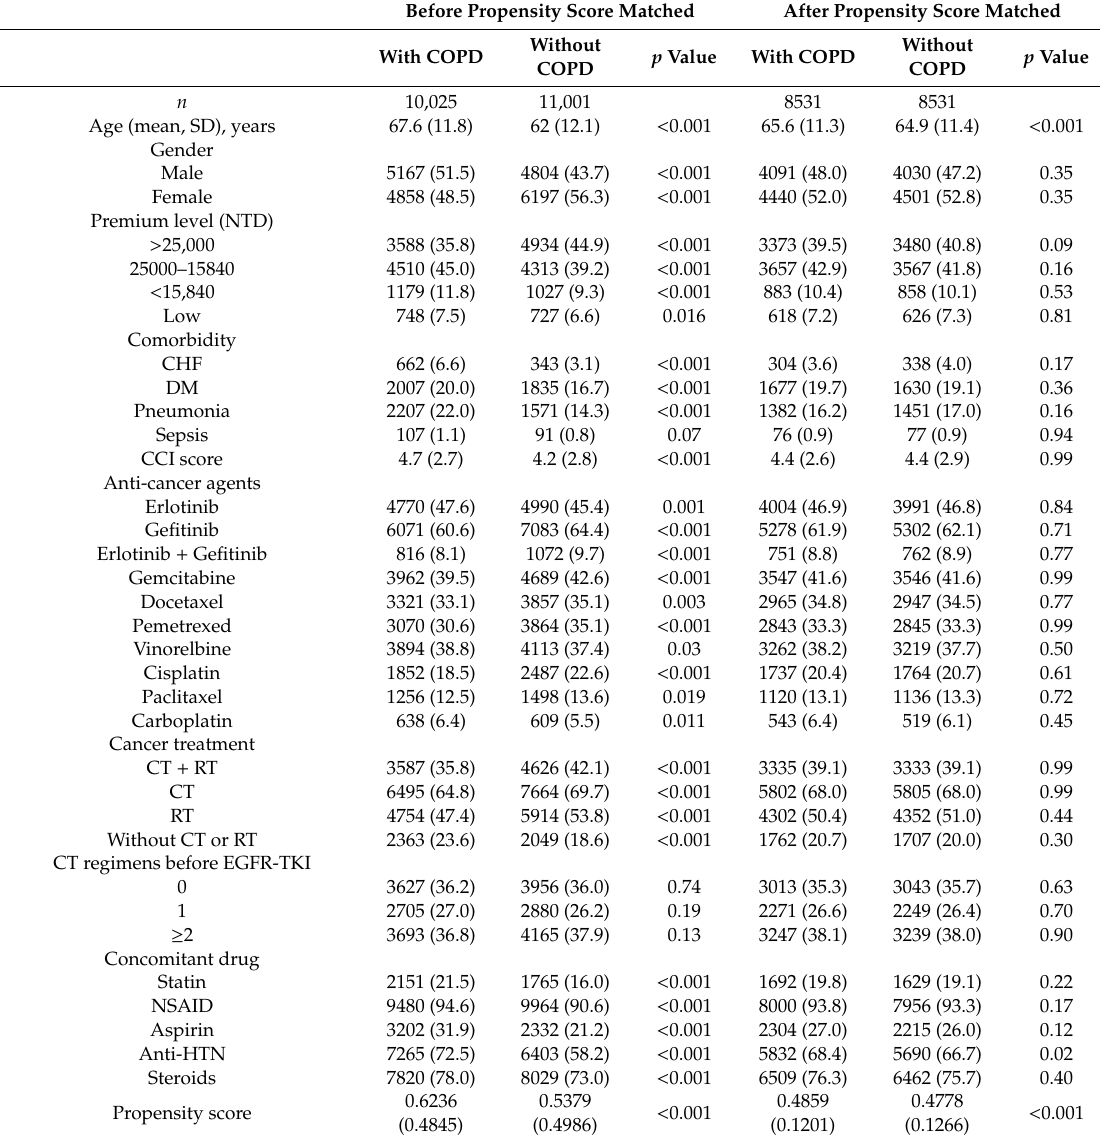
Table 1. The demographic characteristics of lung cancer patients with epidermal growth factor receptor- tyrosine kinase inhibitor (EGFR-TKI). Before Propensity Score